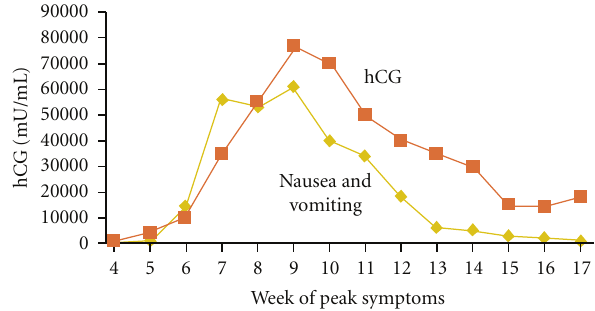
Figure 2: Relation between peak nausea and vomiting symptoms and human chorionic gonadotropin (hCG) levels. Niebyl